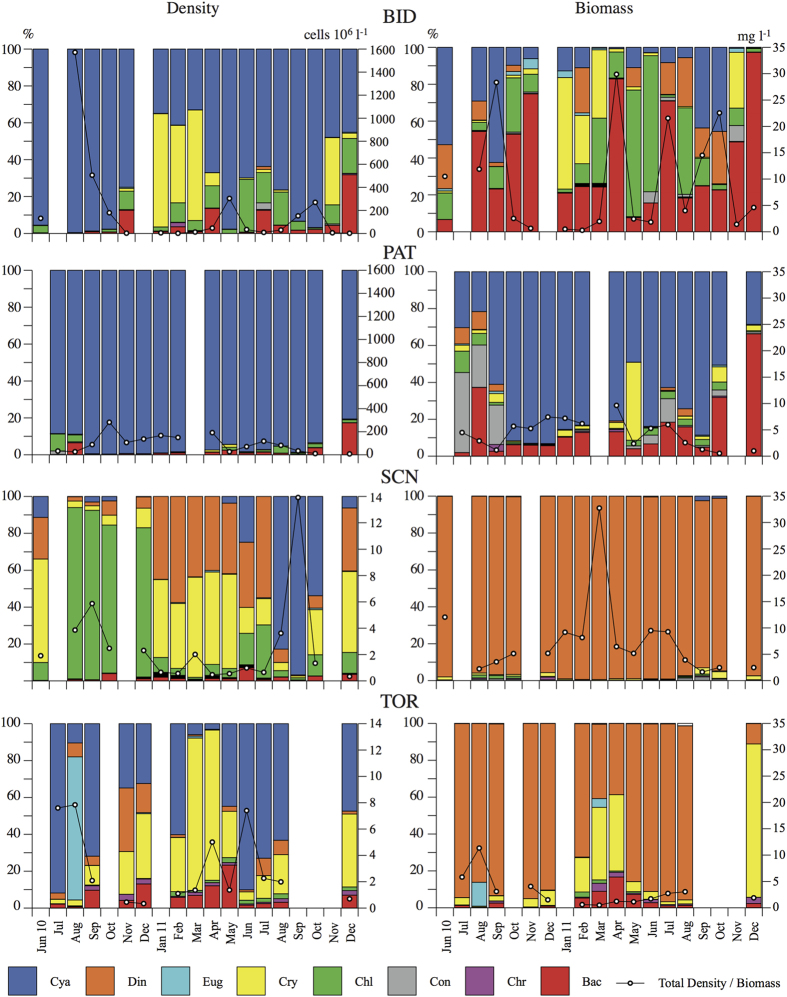
Phytoplankton class composition in terms of cell abundance and biomass with respect to total cell abundance and biomass in Bidighinzu Lake (BID), Pattada Lake (PAT), Sos Canales Lake (SCN) and Torrei Lake (TOR) during the study period.(Bac = Bacillariophyceae; Chr = Chrysophyceae; Con = Conjugatophyceae; Chl = Chlorophyceae; Cry = Cryptophyceae; Eug = Euglenophyceae; Din = Dinophyceae; Cya = Cyanobacteria).